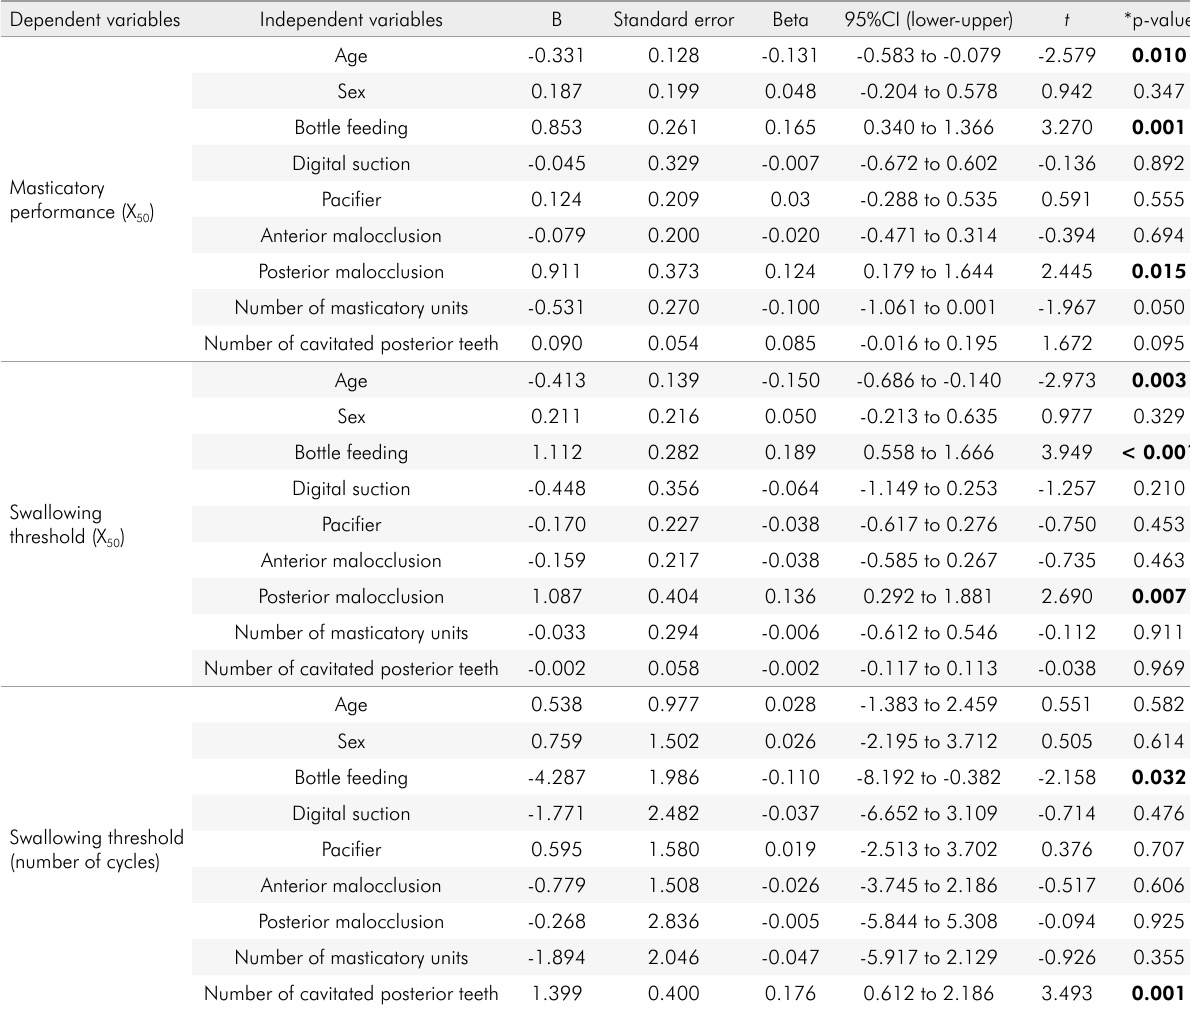
Table 2. Simple linear regression using the test of association between independent variables and parameters for masticatory function (n = 384, Diamantina, Brazil).